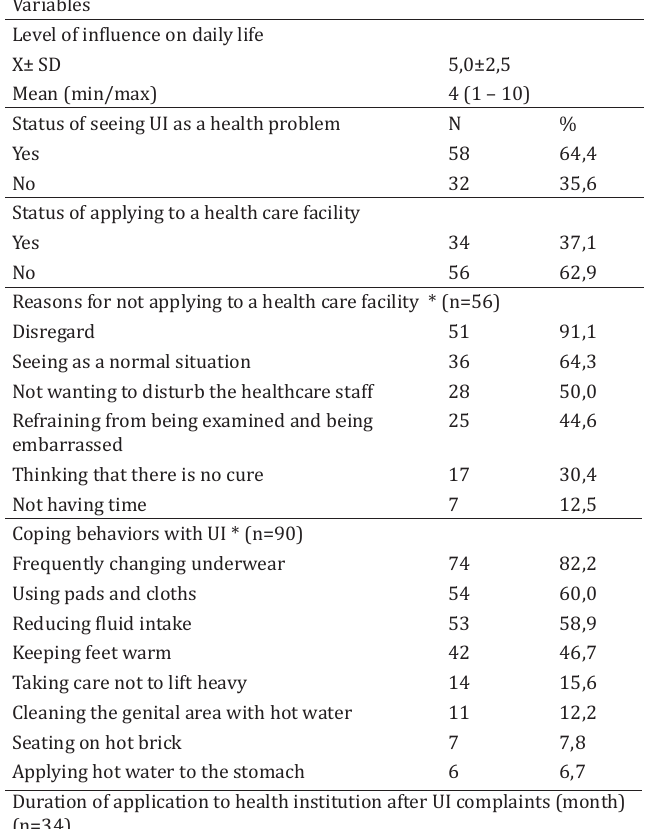
The level of UI affecting the daily life of women, the characteristics of UI about being aware of and coping with UI (n=90)